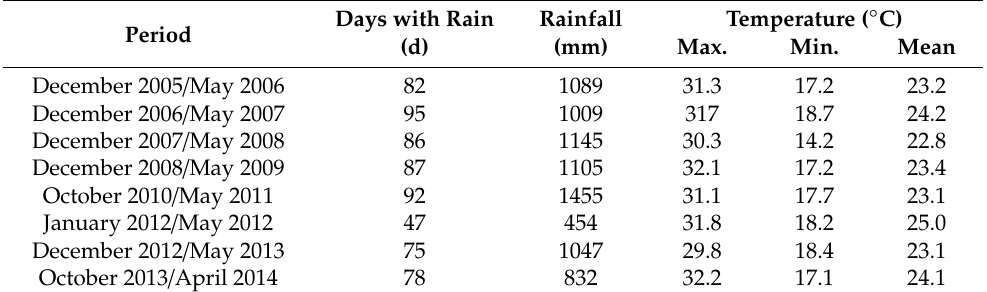
Table 1. Days (d) with rain, rainfall (mm), and average air temperatures during the experimental period. Days with Rain Rainfall Temperature ( ◦ C) Period (d) (mm) Max. Min.